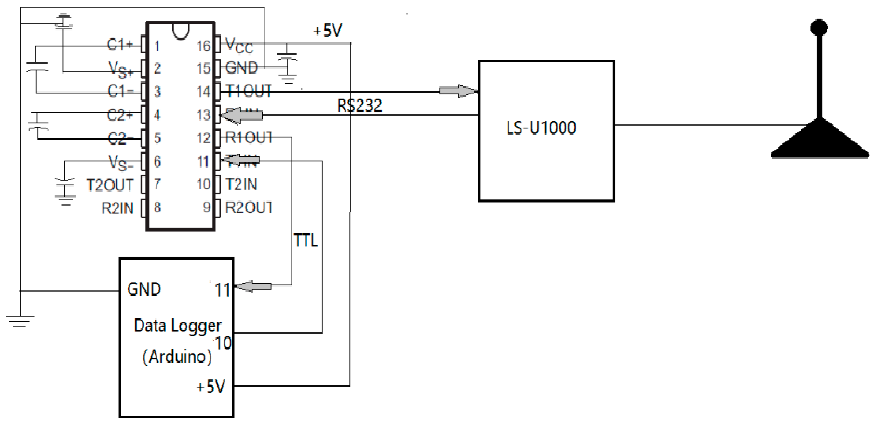
Figure 12. Detailed RS232-TTL interface.